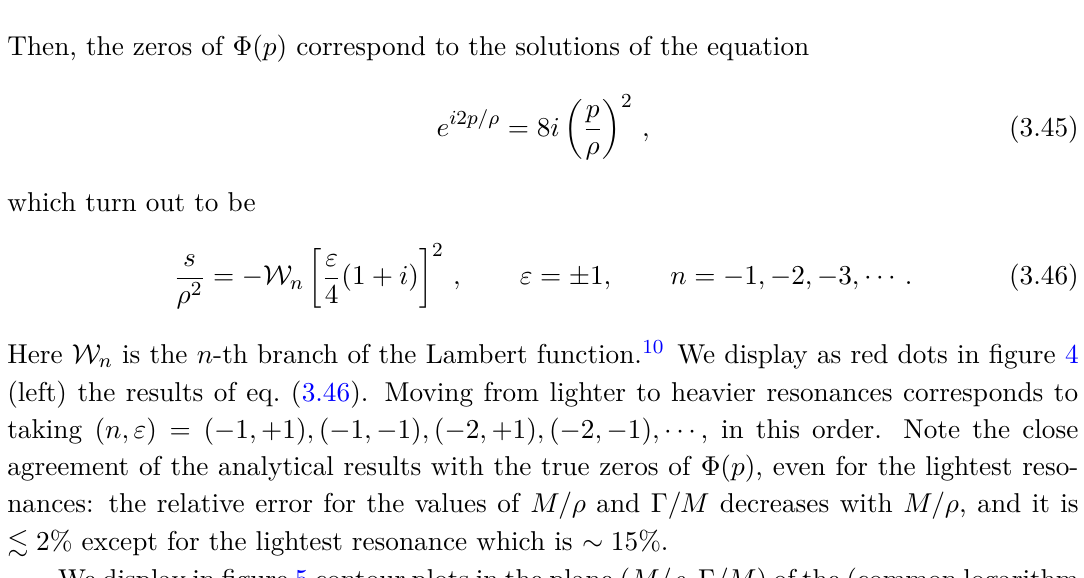
Figure 4 . Left panel: contour plot of log | Φ( p ) | in the plane ( M/ρ, Γ /M ) . The contour lines form 10 small circles around the zeros of Φ( p ) . The (red) dots stand for the positions of the zeros of Φ( p ) as given by the analytical formula of eq. (3.46). Right panel: plot of | Φ( p ) | along an interpolating curve connecting the zeros of Φ( p ) appearing in the left panel. We have used the variables M/ρ and r ≡ Γ /M defined in eq. (3.41). We have considered A 1 = 35